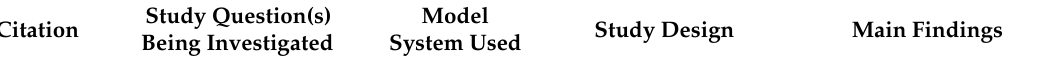
Table 2. Summary of main findings from pre-clinical